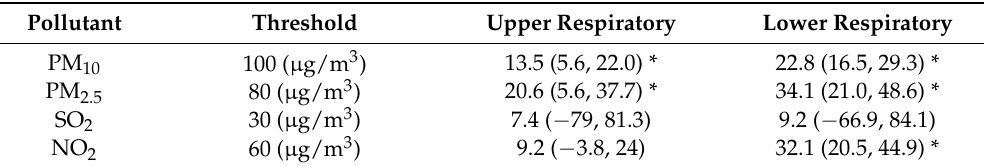
Figure 2. The smoothed exposure response curves of air pollutant concentrations in a lag of 10 days against the relative risk (RR) of acute respiratory infection hospital admission. ( a ) Acute upper respiratory infection; ( b ) Acute lower respiratory infection. Table 3. Percentage increase of total hospital admissions associated with 10 μ g/m 3 increase in air pollutant concentrations within 14 days of lag for acute respiratory infections in Shenzhen in 2013.